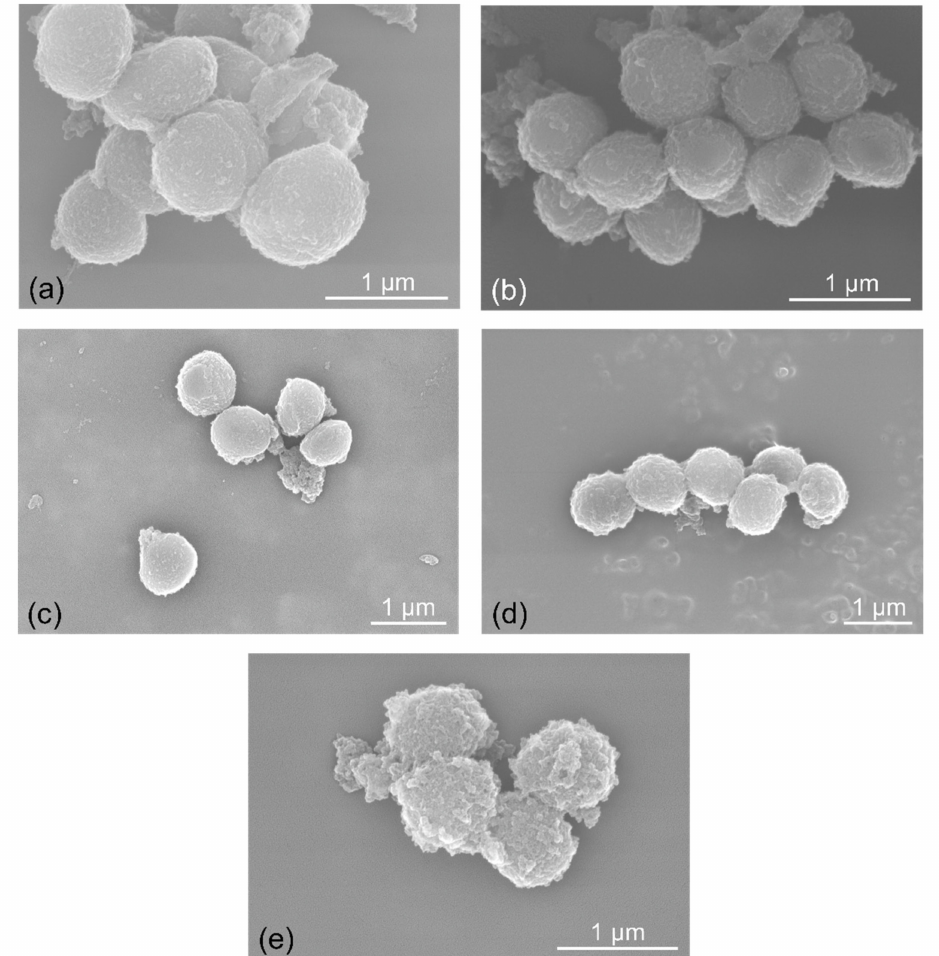
Figure 5. SEM micrographs of the untreated S. aureus strain, ( a ) and compared to the strains treated with ( b ) V. minor , ( c ) V. major , ( d ) V. major var. variegata , and ( e ) V. herbacea leaf extracts at Minimal Inhibitory Concentration